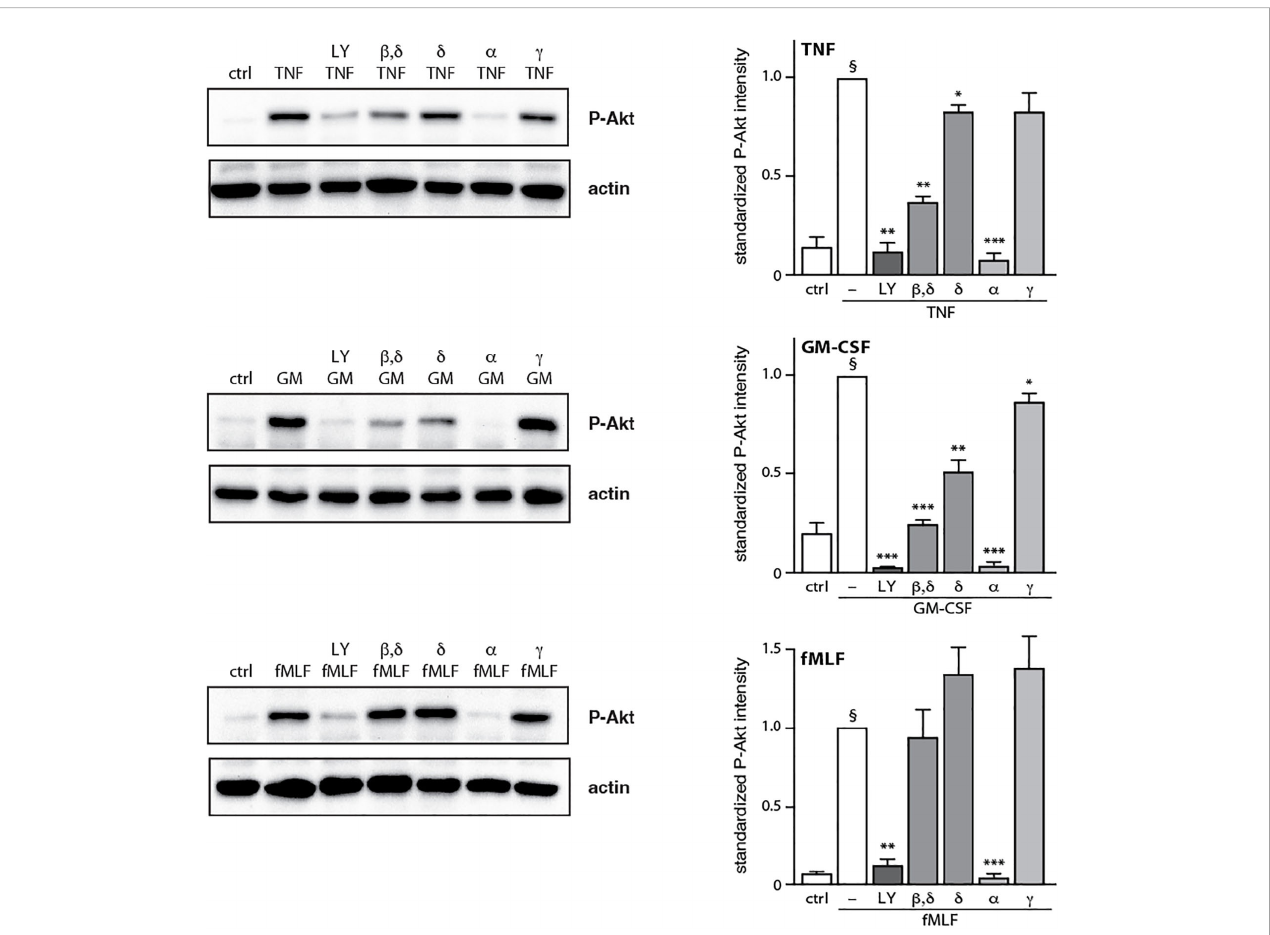
FIGURE 3 Effect of PI3K isoform inhibition on Akt phosphorylation. Neutrophils were pre-treated (15 min, 37°C) with the following PI3K isoform-selective inhibitors or their diluent (0.1% DMSO): 10 m M LY294002 (general PI3K inhibitor); 1 m M TGX-221 ( b , d ); 1 m M IC87114 ( d ); 1 m M PI3K a inhibitor IV ( a ); 1 m M AS64002 ( g ). The cells were then stimulated or not ( “ crtl ” ) for 10 min at 37°C with 100 U/ml TNF a , 1 nM GM-CSF, or 100 nM fMLF. Samples were processed for immunoblot analysis of P-Akt (S473) as well as b -actin (loading control). Representative blots are shown, along with compiled data (mean ± s.e.m.) from at least 3 independent experiments (in which P-Akt values were standardized versus actin and the resulting ratios were divided by that of the corresponding stimulus). *, p<0.05; **, p<0.01; ***, p<0.001 vs stimulus alone. §, p < 0.003 for unstimulated cells vs